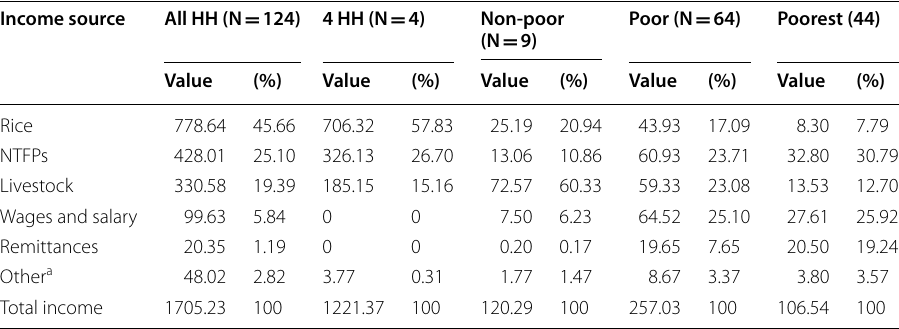
Table 5 Sources of household income by group in the targeted village (2016). Source: Field survey data, March 8,